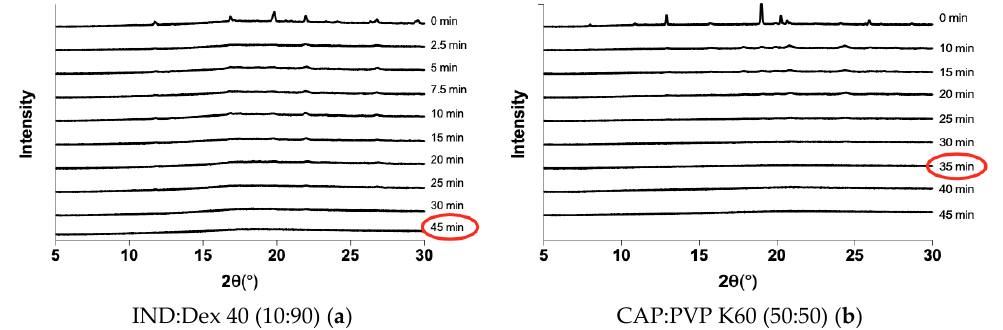
Figure 2. X-ray powder diffractometry (XRPD) diffractograms showing the decrease in crystallinity over time for a mixture of IND and Dex 40 (10:90 w/w) ( a ) and a mixture of CAP and PVP K60 (50:50 w/w) ( b ). The t a is marked with a red circle.